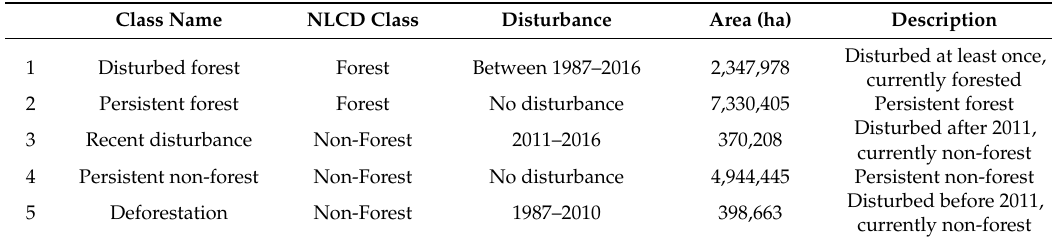
Table 2. Disturbance history classification class.